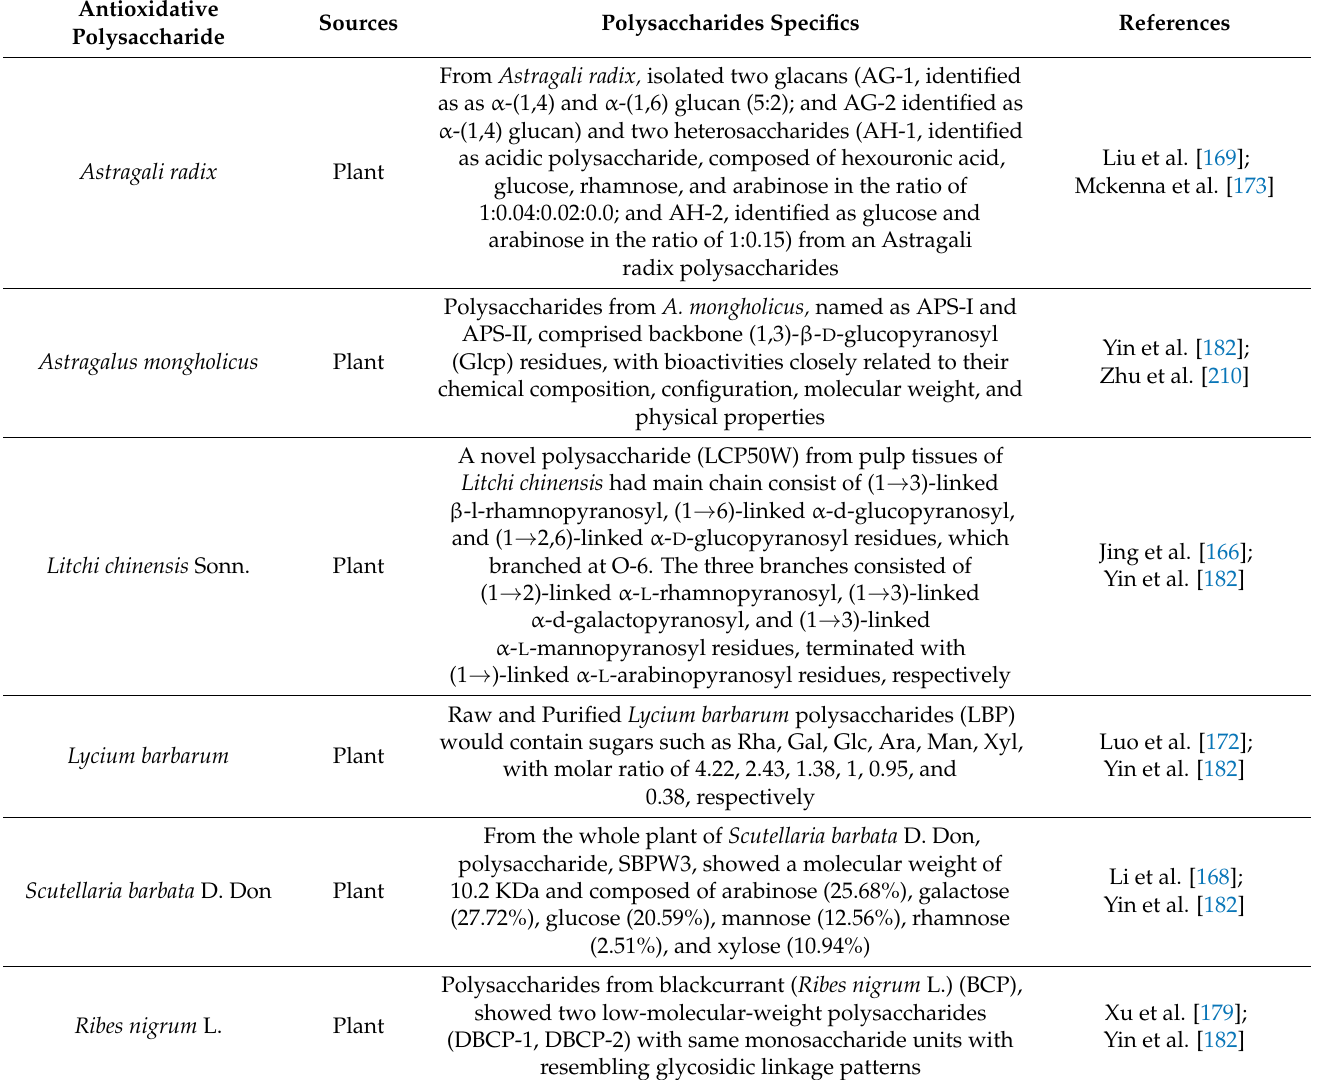
Table 2. Antioxidative polysaccharides, with corresponding sources, and polysaccharides specifics.